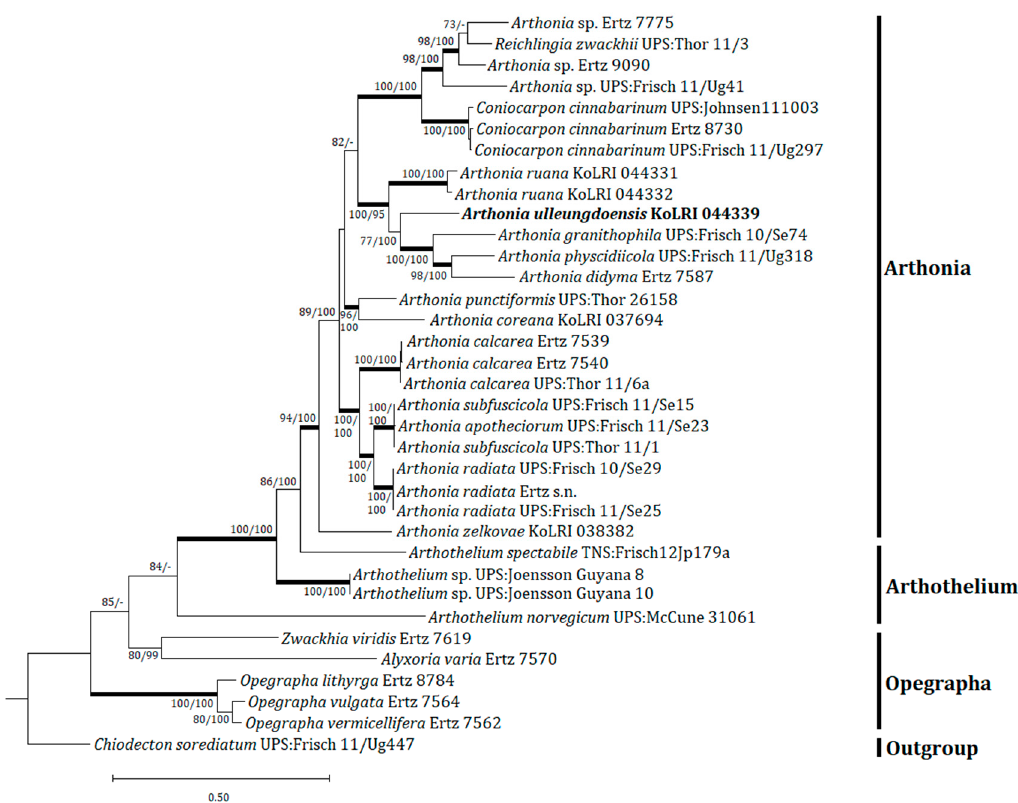
Figure 2. Phylogenetic relationships among the closely related species in the genera Arthonia and Arthothelium based on a maximum likelihood analysis of the concatenated dataset of all mitochondrial small subunit (mtSSU) and RNA polymerase subunit II (RPB2) sequences. The tree was rooted with a Chiodecton sorediatum sequence. Maximum likelihood bootstrap values ≥ 70% and posterior probabilities ≥ 95% are shown above internal branches. Branches with bootstrap values ≥ 90% are shown in bold. The new species Arthonia ulleungdoensis is presented in bold, and all species names are followed by the voucher information. Reference Table 1 provides the species related to the specific GenBank accession numbers and voucher information. Table 1. Species list and DNA sequence information employed for phylogenetic analysis.